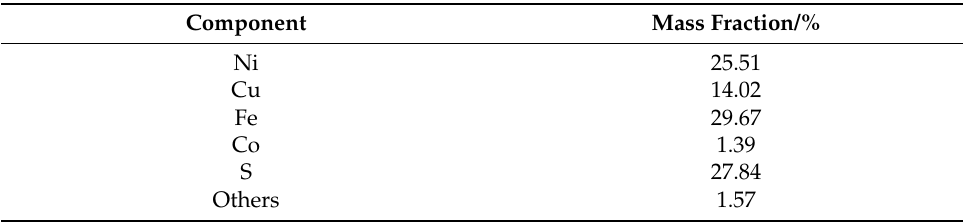
Table 2. Chemical compositions (wt%) of the main minerals in the low-nickel matte.